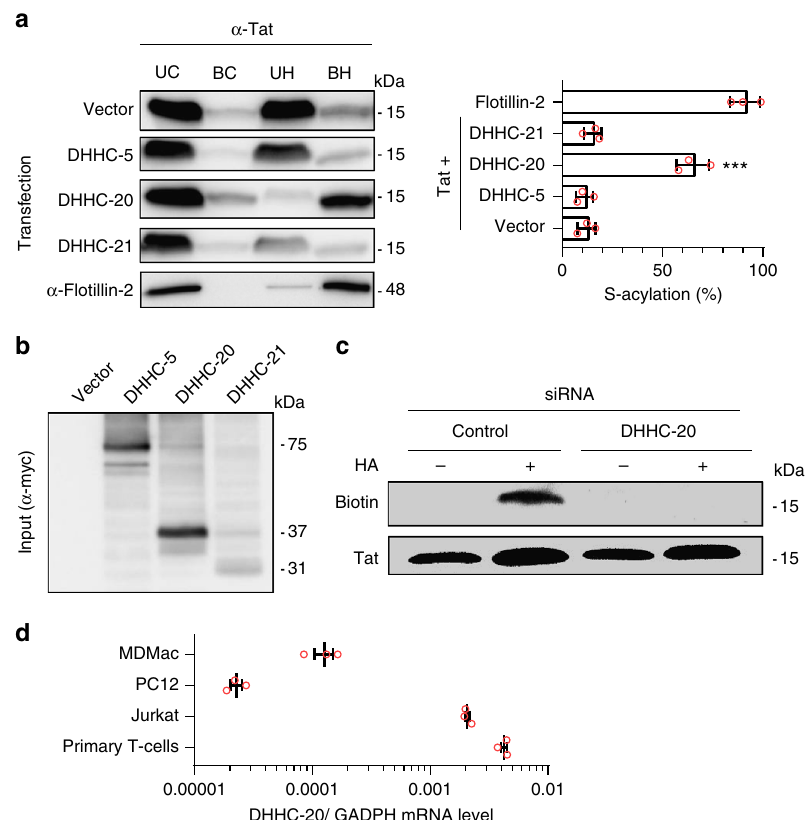
Fig. 3 Tat palmitoylation is performed by DHHC-20. a HEK 293 T cells were cotransfected (1/5) with the indicated myc-tagged human DHHC and Tat. Tat palmitoylation was then assessed using the acyl-RAC technique, UC unbound control, BC bound control, UH unbound hydroxylamine, BH bound hydroxylamine. Palmitoylated Tat is present in the BH fraction. Palmitoylation was calculated as BH/(BH + UH)-BC/(BC + UC), and fl otillin-2 was used as a positive control. The graph shows mean ± SEM of n = 3 independent experiments, *** p < 0.001 (one-way ANOVA). b DHHC-myc overexpression level was assessed using anti-myc western blot. DHHC-5, -20, and -21 migrated at 75, 37 and 31 kDa, respectively. Transfection ef fi ciency was 60 – 70%. c PC12 Cells were cotransfected with Tat-FLAG and the indicated siRNA before detecting Tat palmitoylation using acyl-biotin exchange. The ef fi ciency of siRNA- mediated silencing is shown in Supplementary Fig. 6. d The RNA from monocyte-derived macrophages (MDMac), PC12, Jurkat or human primary CD4 + T- cells was extracted before quanti fi cation of DHHC-20 and GAPDH mRNAs using qRT-PCR. Results are expressed as DHHC-20/GAPDH ratio. Results for all DHHCs are shown in Supplementary Fig. 7. Mean ± SEM, n = 3 independent